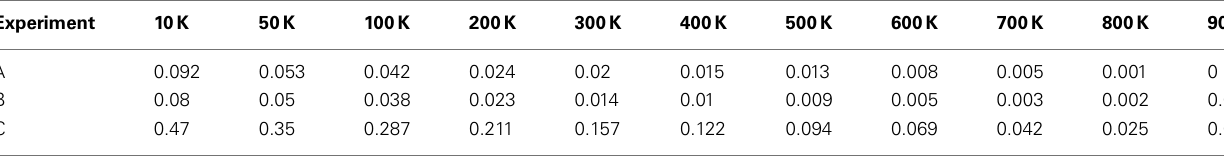
TableA2 | Proportion of masses with max sizes surpassing thresholds.